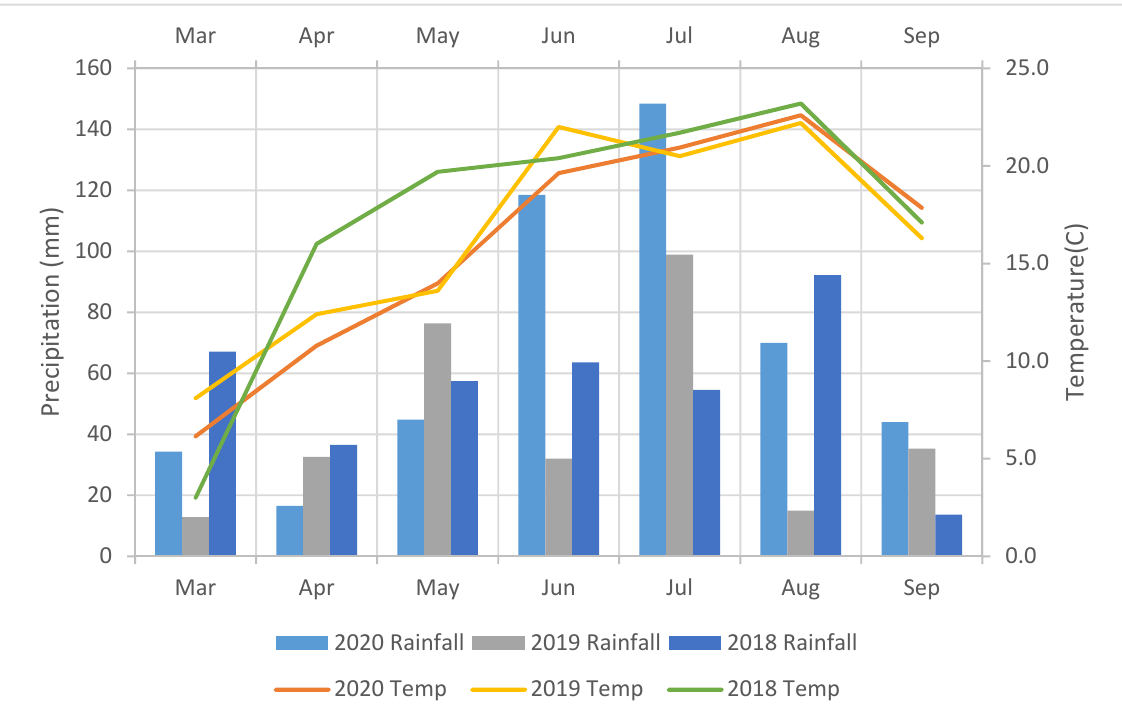
Figure 1. Monthly mean temperature and precipitation in 2018–2020 in Debrecen.